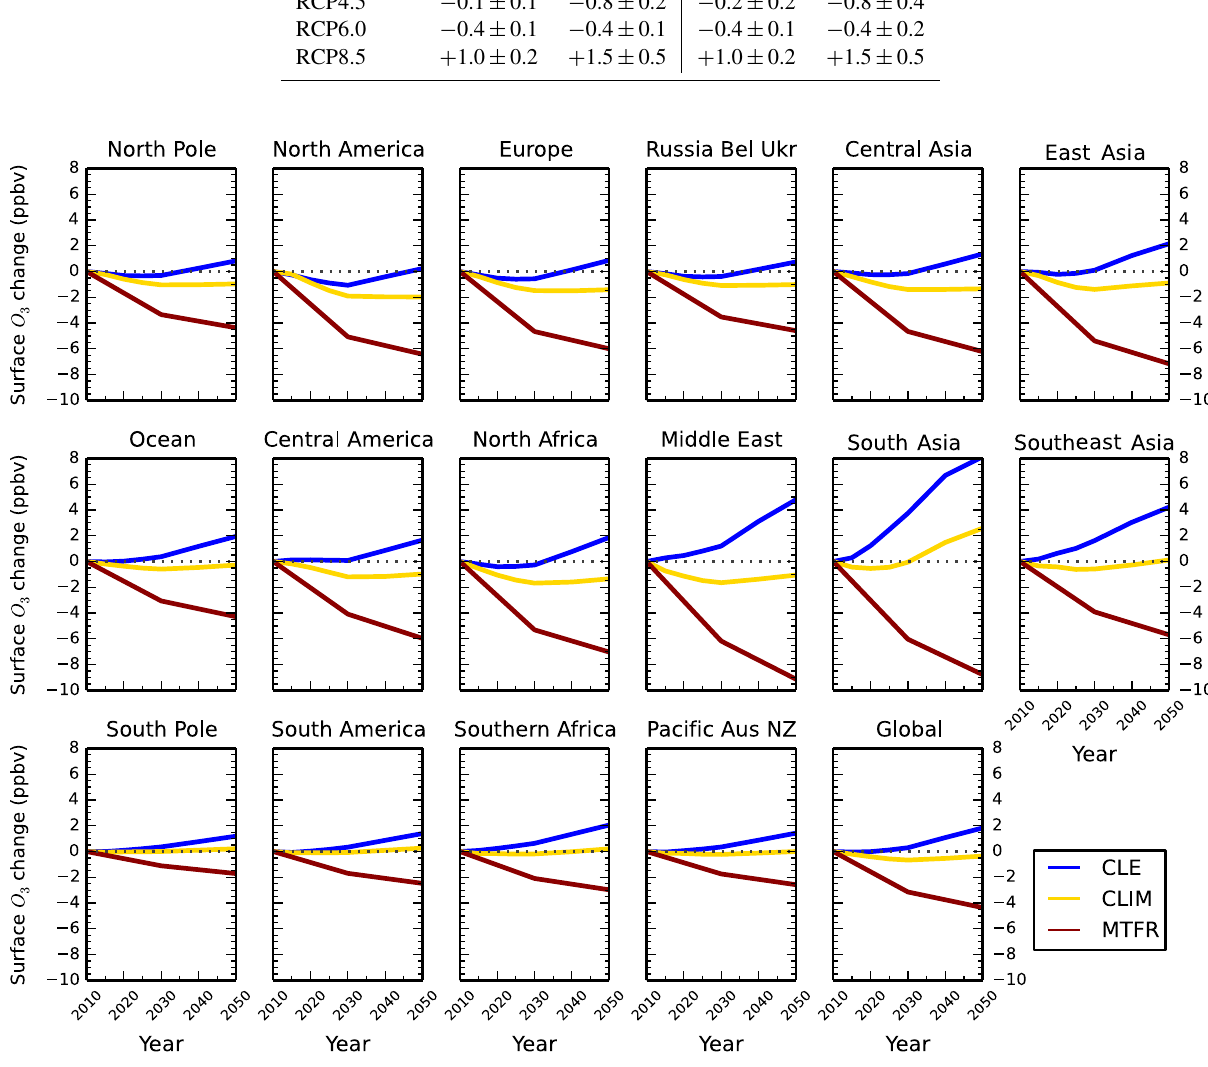
Figure 6. Annual mean change in regional surface O 3 concentrations between 2010 and 2050 from the parameterisation for the ECLIPSE V5a emissions under the CLE (blue), CLIM (gold) and MTFR (red)